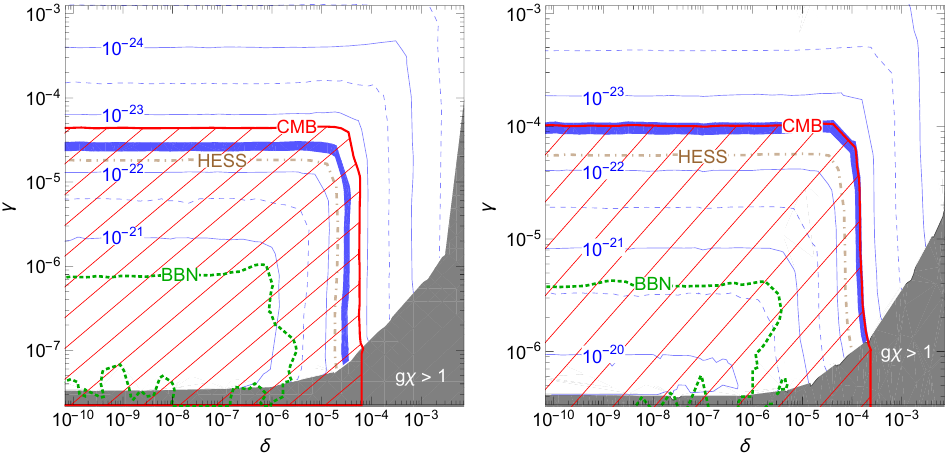
Figure 4 . SA cross-sections in the galaxy today after imposing the relic density constraint, in the ( (cid:14) { (cid:13) ) plane, for the sequential two-body (left) and three-body (right) decay modes. The blue contours are labelled in cm 3 s (cid:0) 1 ; the shaded blue regions explain the results of section 6. The red hatched area is excluded by CMB measurements; we also show sub-leading constraints from H.E.S.S. observations of the galactic centre (brown dot-dashed line) and BBN (green dotted line). The grey shaded area is where the relic density can not be obtained with SA coupling g (cid:31) < 1. The CMB constraints fully (partially) exclude the S2B (3B) preferred region, but these bounds can be weakened in the presence of a small O (1) substructure enhancement. See the text for more details.